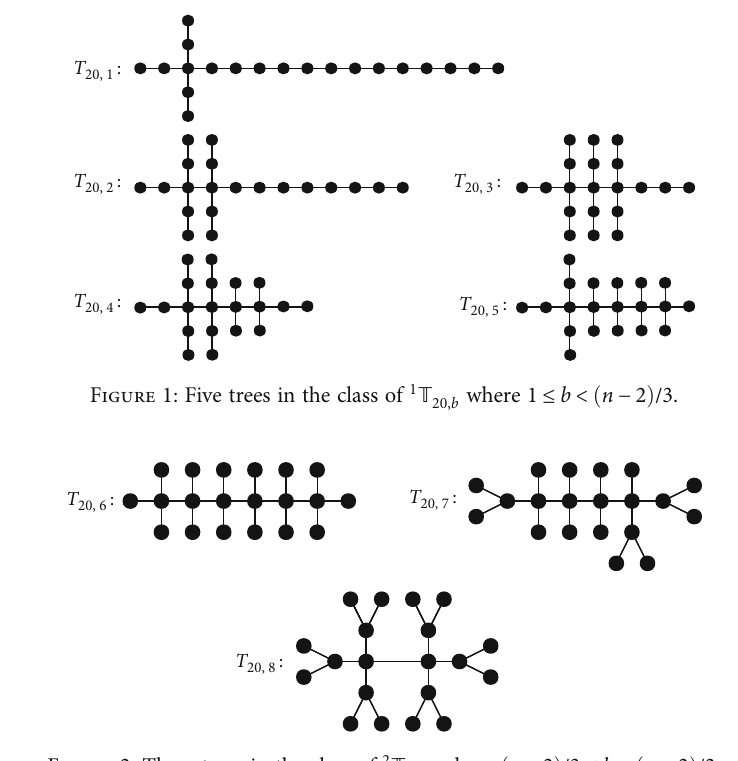
Figure 2: Three trees in the class of 2 T